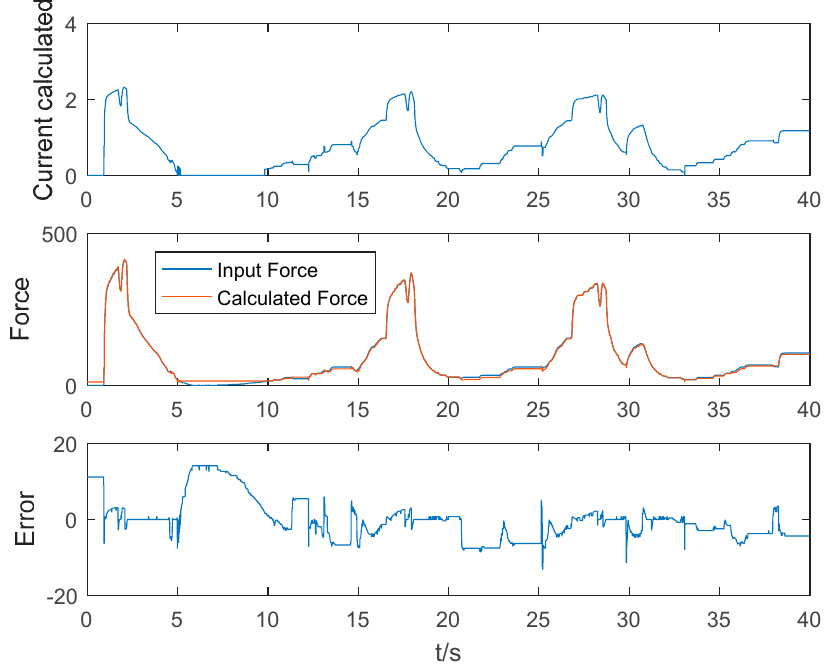
Figure 8. Comparison of the measured and the reference